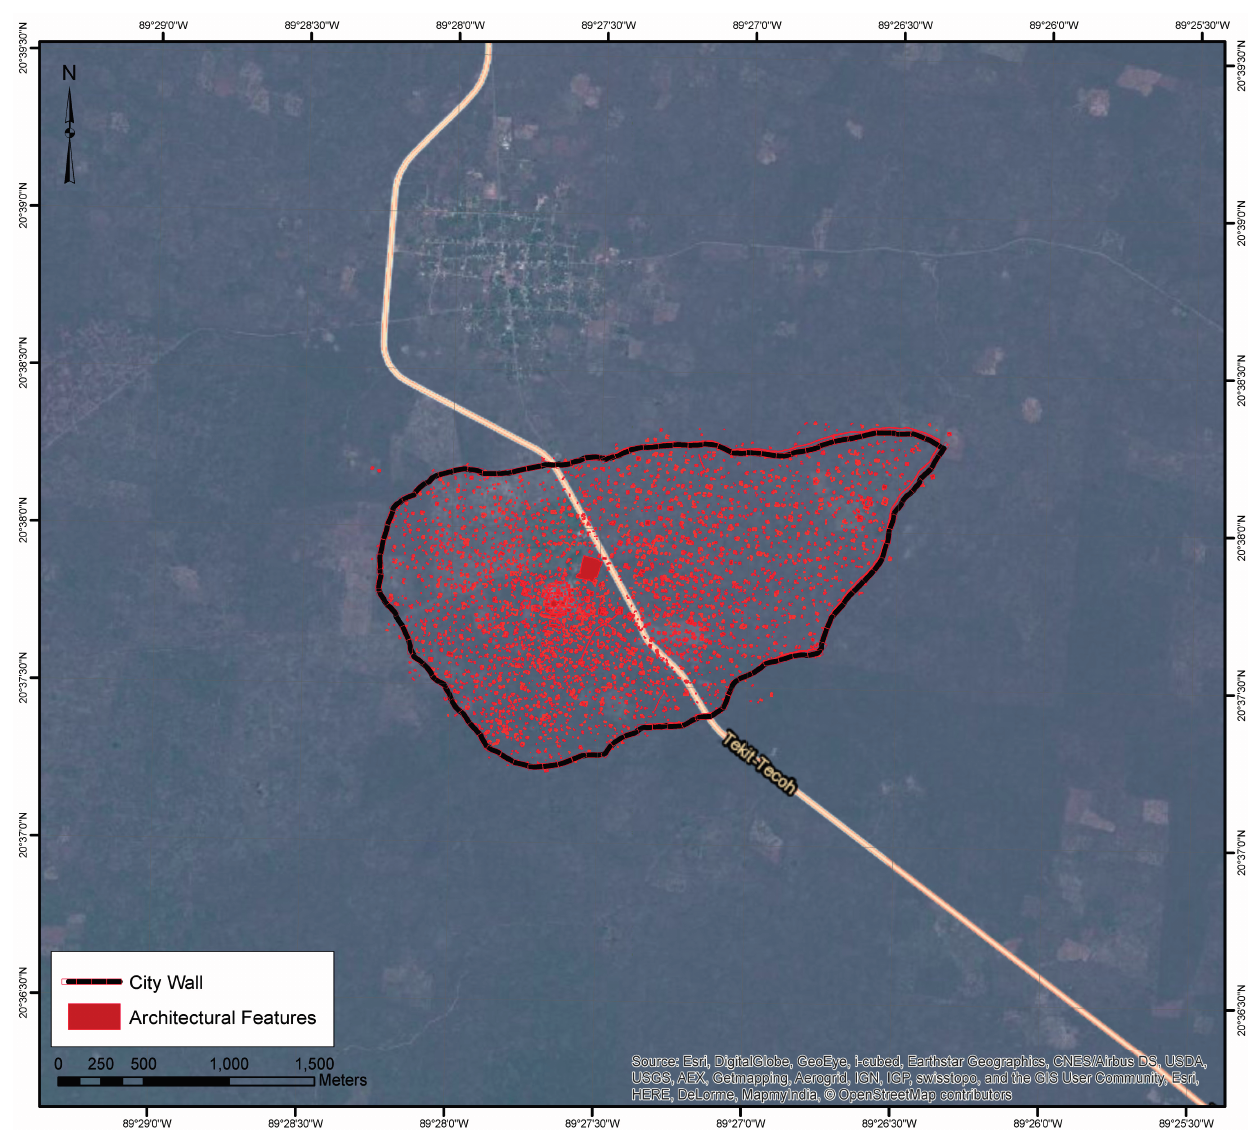
Figure 2. Carnegie mapped features in the context of the regional survey. The city wall is black and general architectural features are